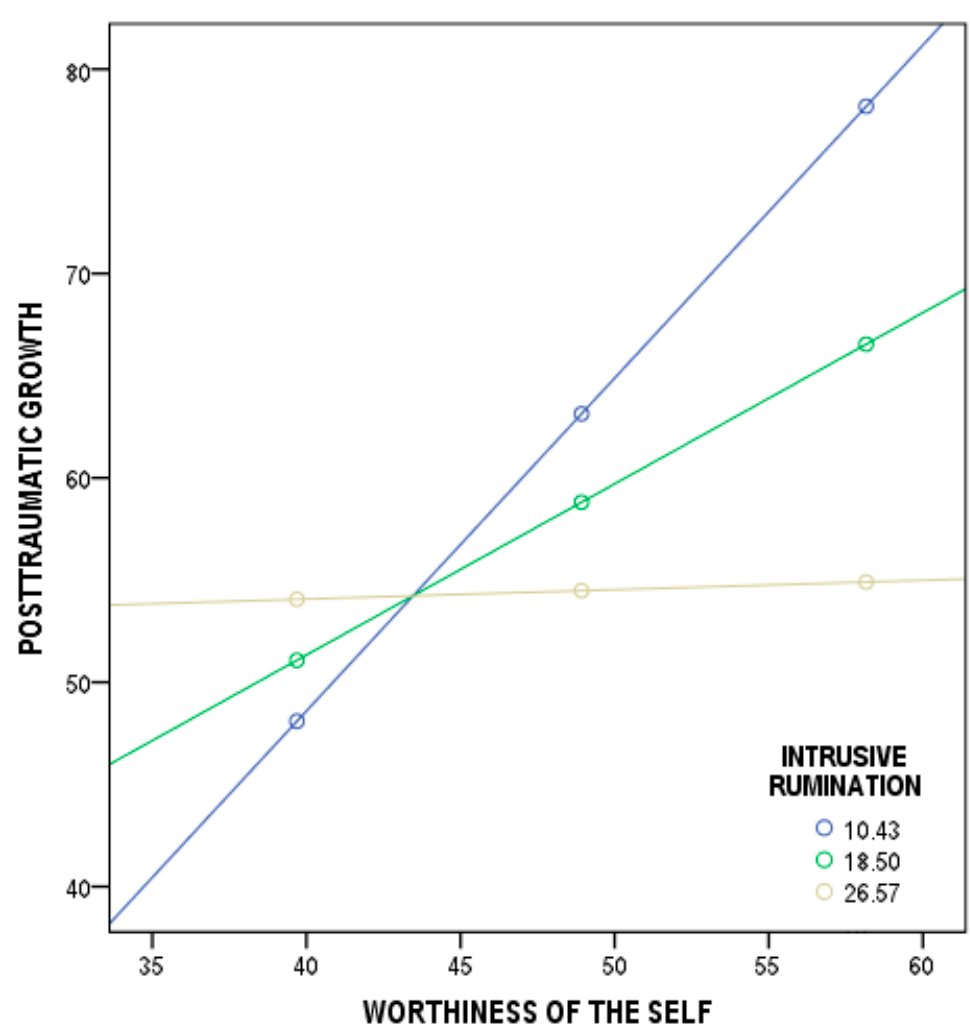
Figure 2. Plot of the slope analysis for the moderating effect of intrusive rumination in the relationship between worthiness of the self and post-traumatic growth.